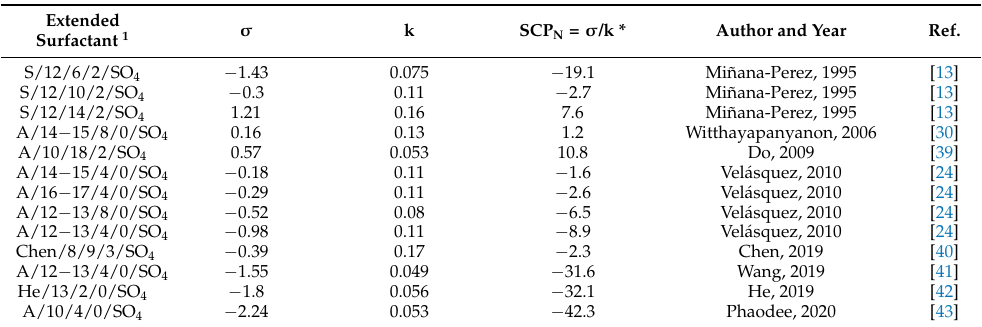
Table 1. Molecular structure and classification of sulfate head extended surfactants according to its normalized characteristic parameter (SCP N )